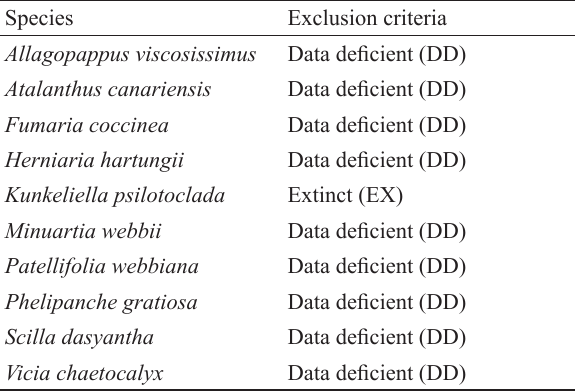
Table 1. Species excluded for the analysis and its justification Species Exclusion criteria